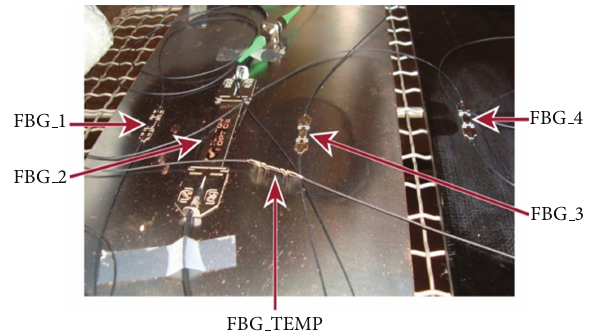
Figure 2: FBGS instrumented in the steel and CFRP